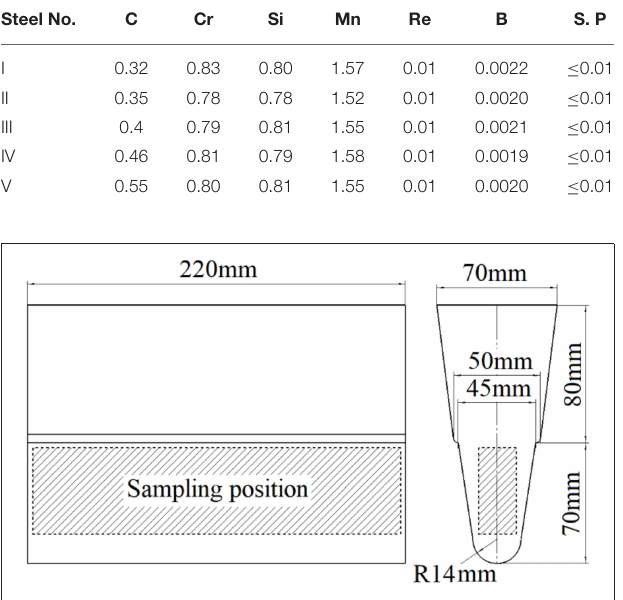
FIGURE 1 | Y-shape casting ingot.